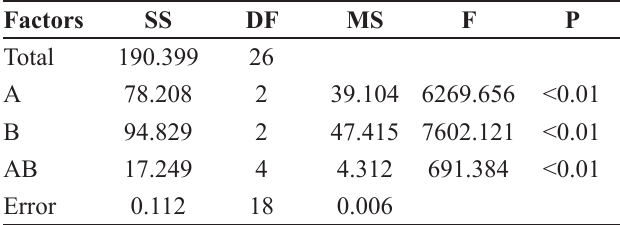
TABLE V - Variance